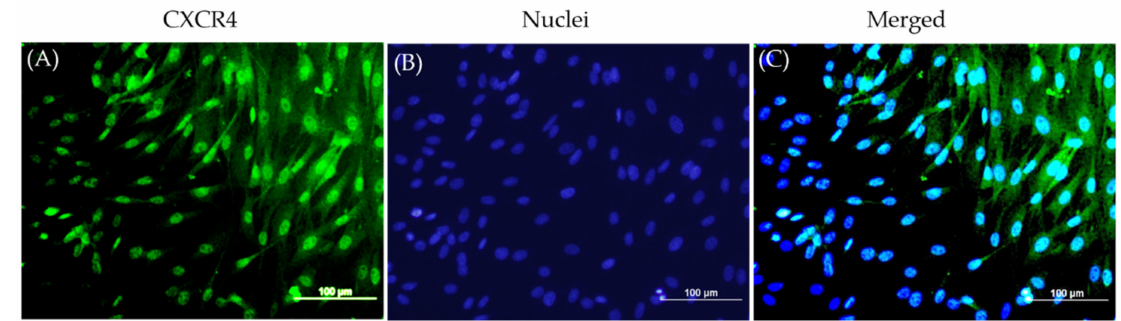
Figure 2. CXCR4 expression on bMSCs ( A ) bMSCs in monolayer stained by immunofluorescence with an anti-CXCR4 antibody (green). ( B )Nuclei counter stained by DAPI (blue). ( C ) Merged CXCR4 and nuclei staining. Scale bars are 100 µ m.